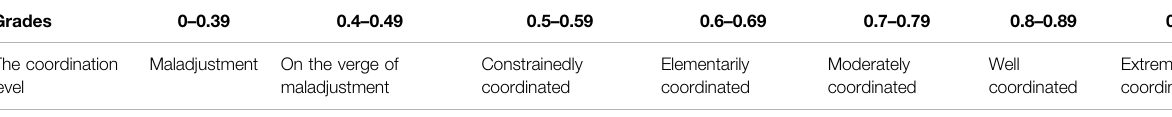
TABLE 3 | Classi fi cation of coupling and coordination levels.